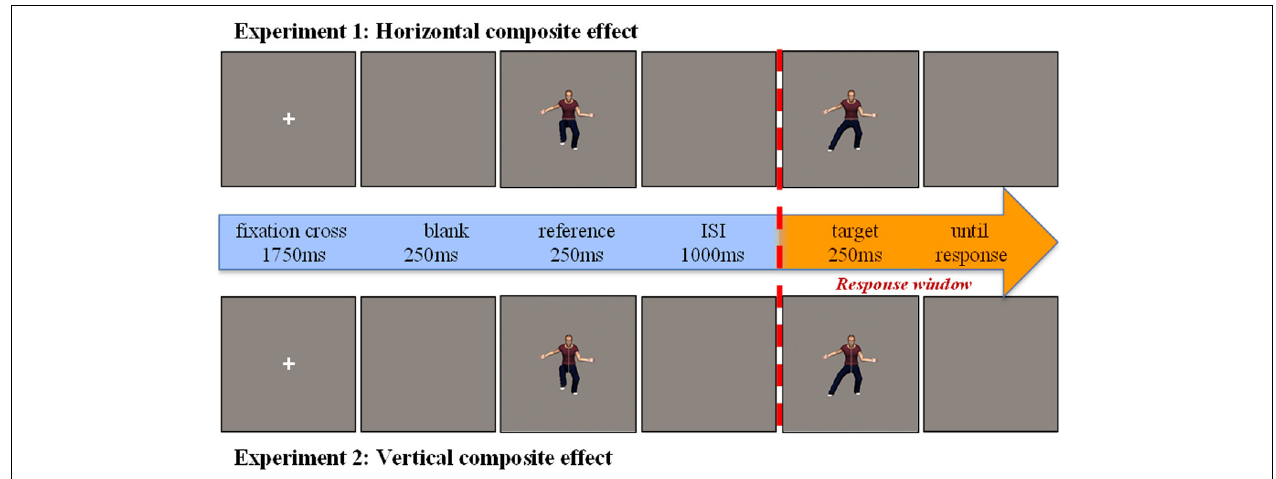
FIGURE 3 | Experimental procedure. In both cases an aligned composite pair is shown in which the relevant body half (i.e., top half and right side, respectively for Experiments 1 and 2) is identical and the irrelevant half differs (i.e., bottom half and left side, respectively for Experiment 1 and Experiment 2).